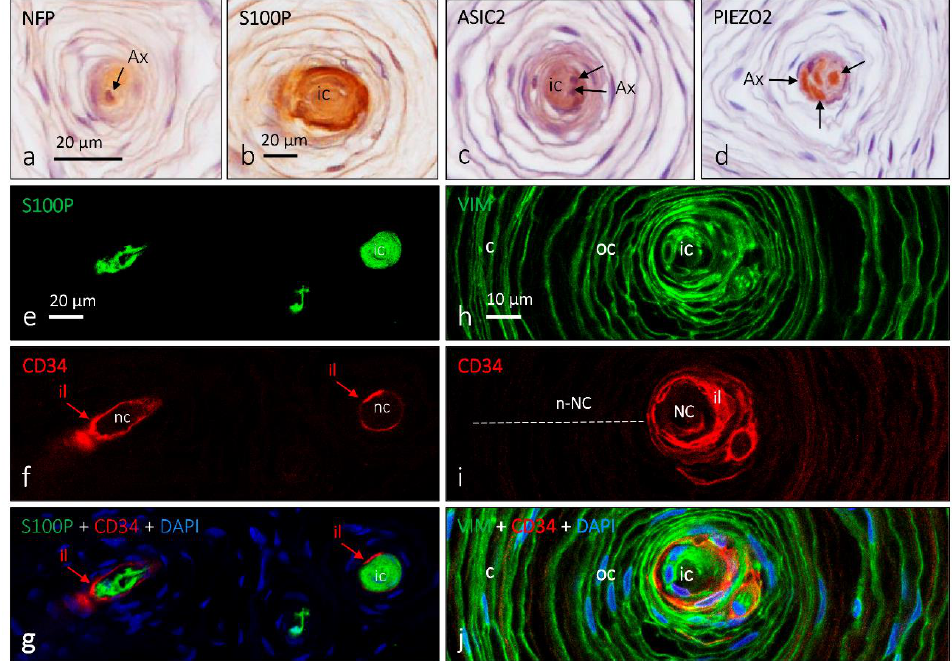
Figure 7. Immunohistochemical profile of human cutaneous Pacinian corpuscles. Immunohistochemical localization of neurofilament proteins (NFP), S100 protein (S100P), acid-sensing ion channel 2 (ASIC2), PIEZO2, CD34 and vimentin in human digital Pacinian corpuscles. Pacinian corpuscles are divided into two main compartments: the neural compartment (NC), which comprises the axon and the glial cells, and the non-neural compartment (n-NC), which comprises both the outer core and the capsule of perineurial origin. Both compartments are separated by an intermediate layer of endoneurial origin. All the Pacinian corpuscle constituents can be selectively immunolabeled. ( a ) The axon displaying immunoreactivity for NFP; ( b ) the inner core lamellae are S100P immunoreactive; ( c , d ) occurrence of the mechanoproteins ASIC2 and PIEZO2, respectively, in the axon; a faint immunoreactivity for ASIC2 is also present in the inner core; ( e – g ) double immunofluorescence, demonstrating that lamellar cells forming the inner core display the S100P and are covered by a layer of endoneurial-related cells (CD34-positive), the so-called intermediate layer; ( h – j ) double immunofluorescence, demonstrating that the lamellar system of Pacinian corpuscles (inner core, intermediate later, outer core, capsule) display vimentin and the division of Pacinian corpuscles into NC (within the CD34+ intermediate layer) and n-NC. Ax: axon; c: capsule; ic: inner core; il: intermediate layer; oc: outer